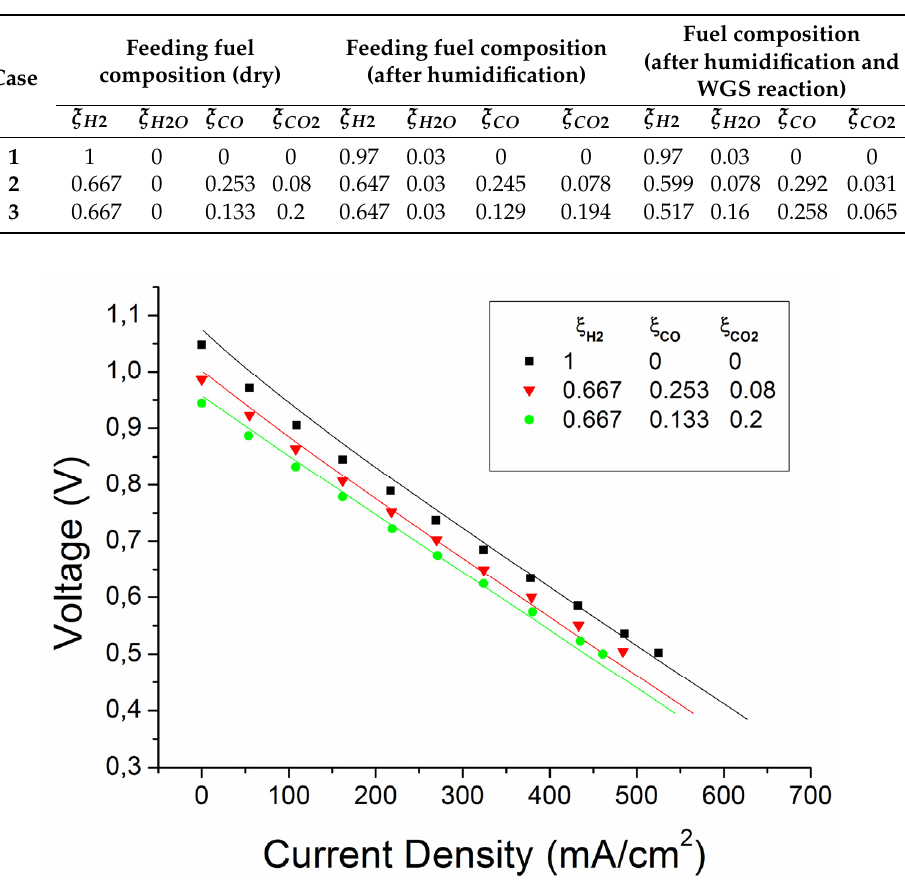
Figure 5. Further model validation with three different H 2 /CO/CO 2 fuel compositions (Table 3). Operating temperature: 950 °C. Fuel flow rate 10 Nl/min. Symbols: experimental. Lines: simulations.